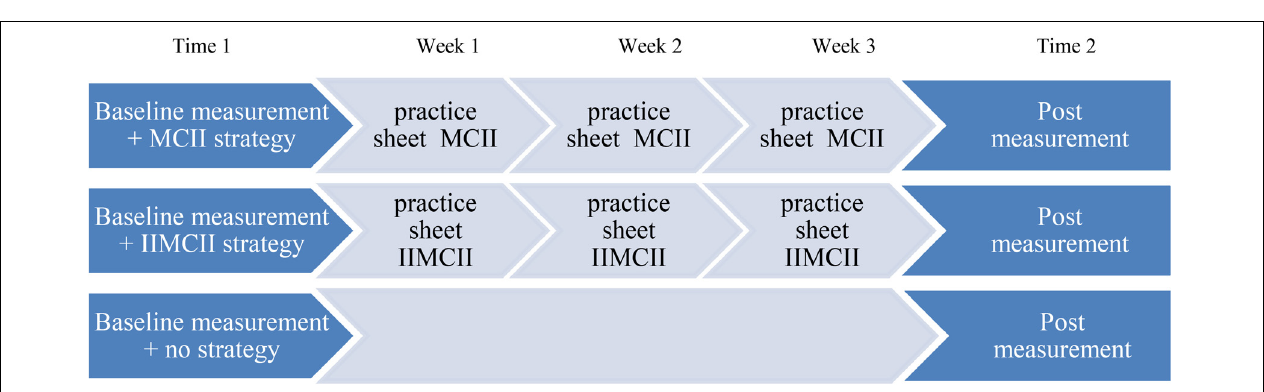
questionnaire. The missing values of 24 participants at Time 2 were replaced by their respective baseline